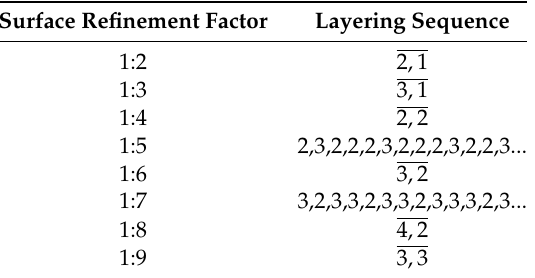
Table 1. Our proposed layering sequences for different surface refinement factors. Each number in the sequence is how many layers normal layers should split into at the corresponding level of refinement. An overline indicates that the sequence repeats indefinitely. For semiregular prismatoid refinement, since the initial discretization has no normal layers, these sequences are used starting with the second